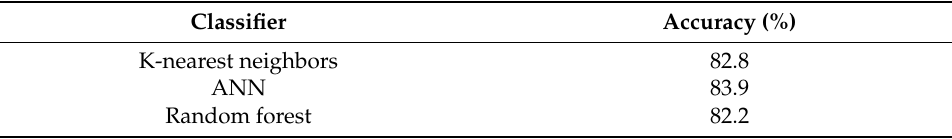
Table 11. Accuracy score for each algorithm: ethanol.